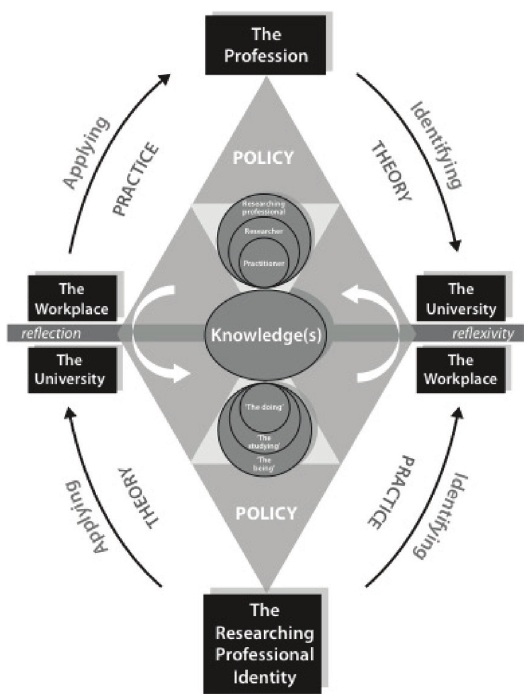
Figure 4: Theorizing the uniqueness of the professional doctorate